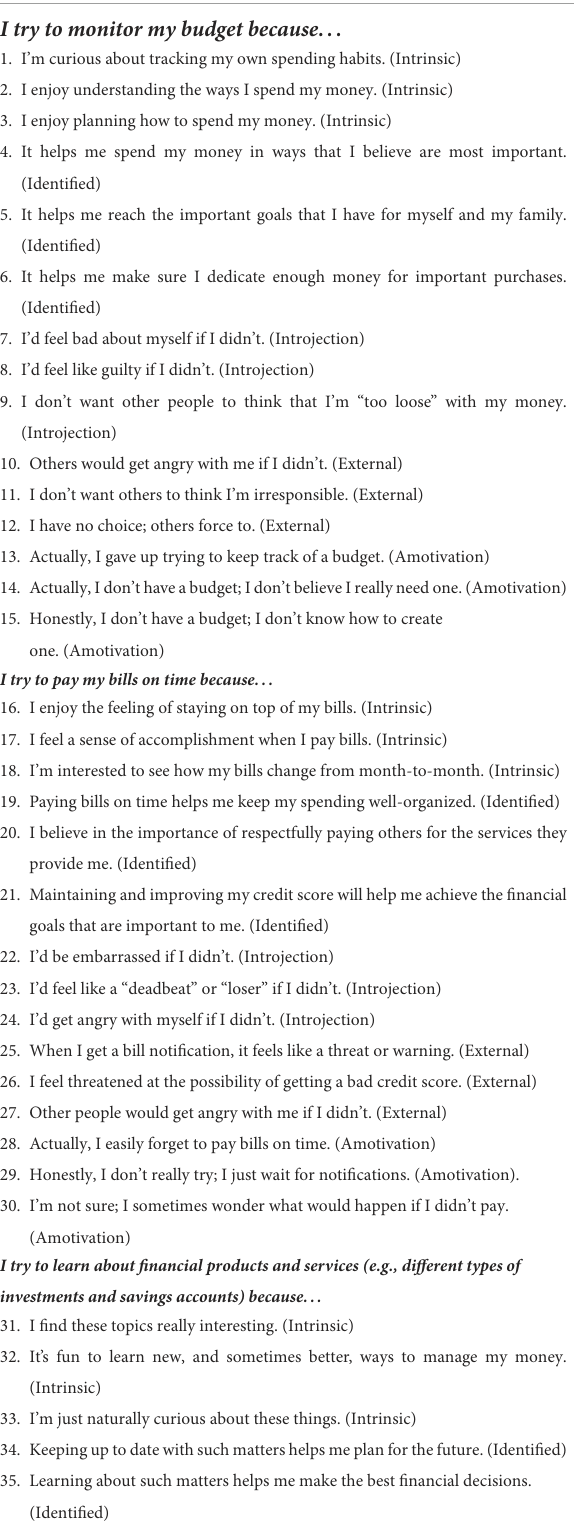
TABLE 3 Financial motivation PLOC